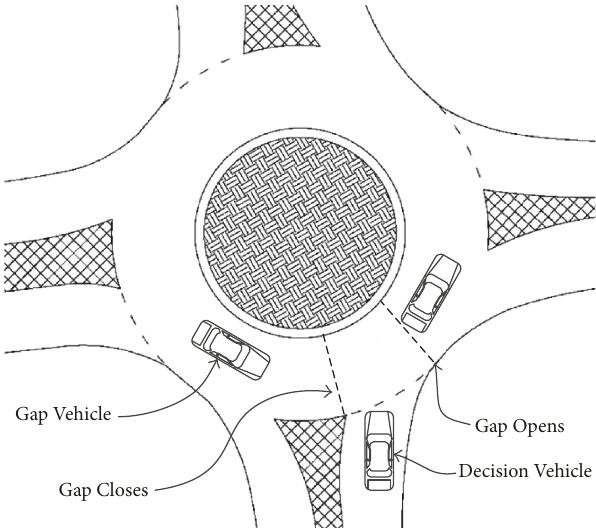
Figure 1: Gap acceptance definition.